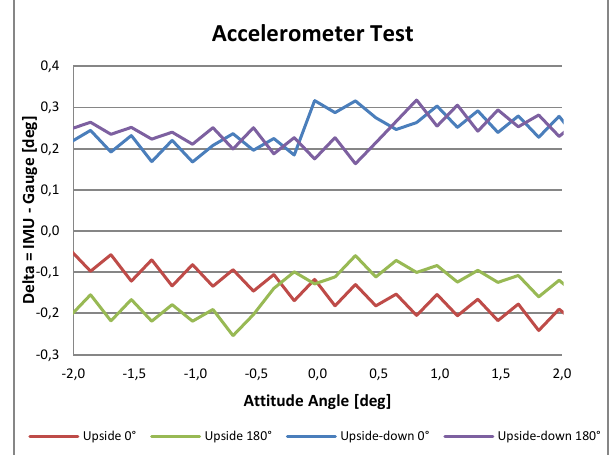
Figure 12. Attitude-angles of the accelerometers compared to a gauge measurement